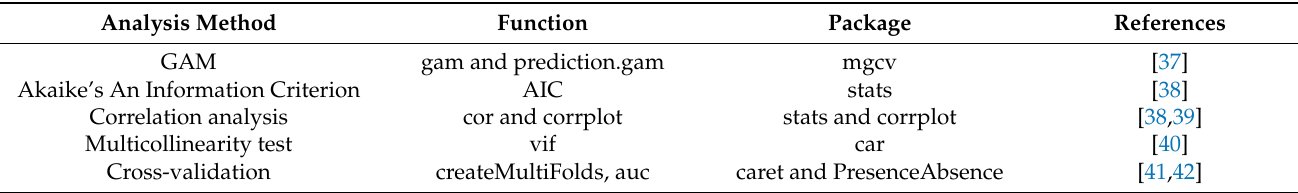
Table 2. Summary of the functions and packages used in the analyses.